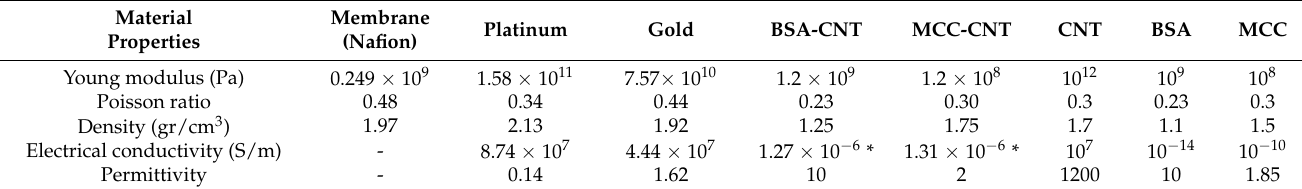
Table 1. Material properties of electrodes, membrane, and basic